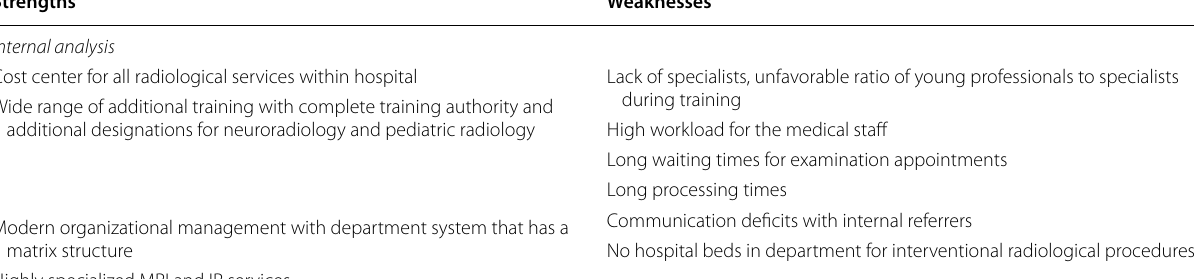
CME: continuing medical education, IR: interventional radiology, MRI: magnetic resonance imaging, PR: public relations